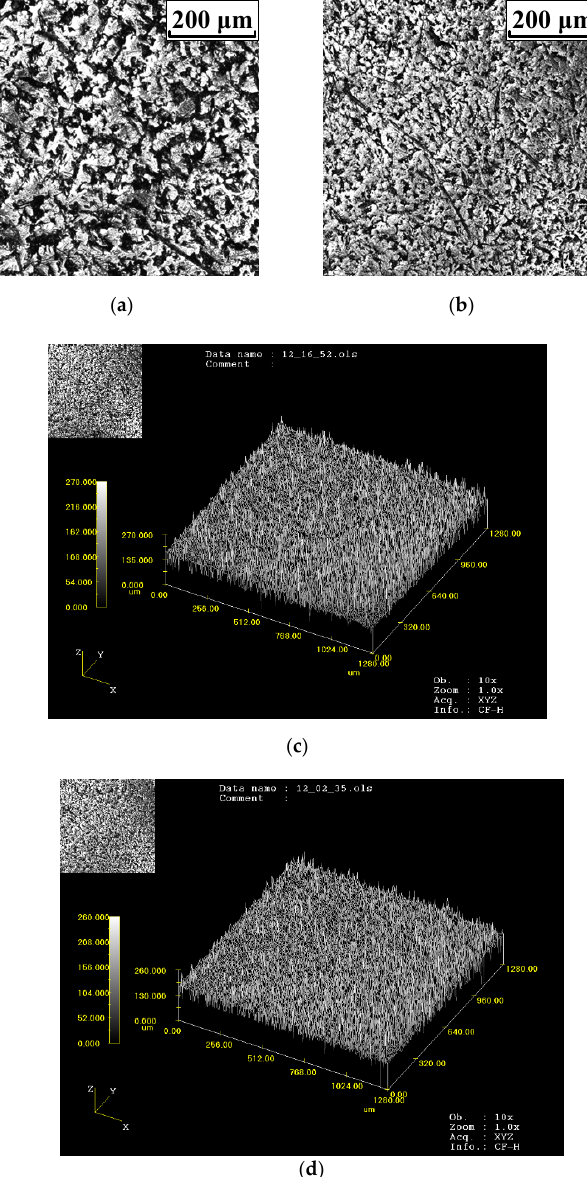
Figure 5. The laser confocal pictures for the bright and matt electrodes. ( a ) The surface topography of the bright electrode. ( b ) The surface topography of the matt electrode. ( c ) The surface wireframe of the bright electrode. ( d ) The surface wireframe of the matt electrode. Table 1. Experimental conditions.